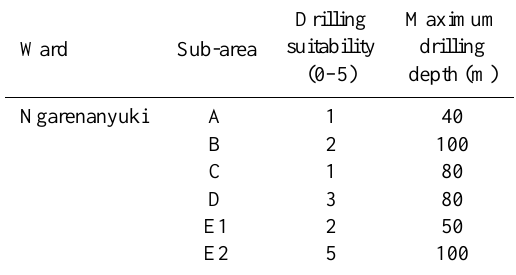
Table 3. Operative synthesis of the survey results. Columns 3 and 4 show, respectively, drilling suitability and a suggested maximum drilling depth. The former is scaled from 0–5, where “0” = do not drill at all, and “5” = area particularly suitable for drilling. The sub-areas in the second column are shown in Fig.